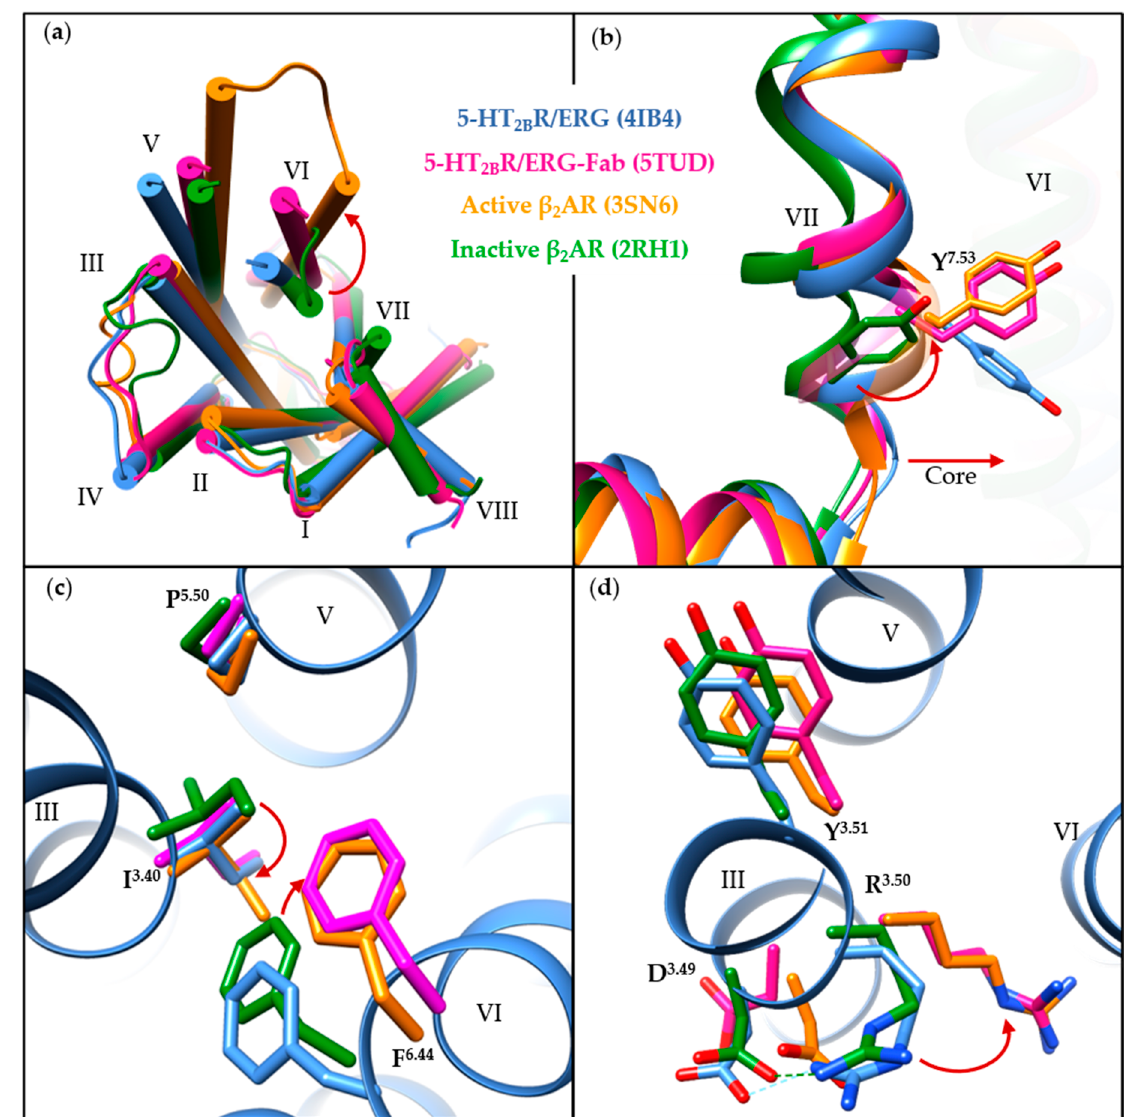
Figure 3. A comparison of the 5-HT 2B R/ERG (cornflower blue, PDB ID: 4IB4), the 5-HT 2B R/ERG-Fab (magenta, PDB ID: 5TUD), the active-state β 2 AR (orange, PDB ID: 3SN6) and the inactive-state β 2 AR (forest green, PDB ID: 2RH1) crystal structures. ( a ) Intracellular view of the overall architecture. The outward movement of helix VI upon activation is indicated by a red arrow. ( b ) A comparison of structural features in helix VII. The slight inward movement of helix VII and rotation of Y 7.53 in the NPxxY motif towards helix VI are highlighted by red arrows. ( c , d ) A comparison of the residues in ( c ) PIF and ( d ) D(E)RY motifs. For clear visualization, residues apart from the motif are hidden, with the exception of the 5-HT 2B R/ERG structure (PDB ID: 4IB4). The obvious conformational changes of specific residues upon activation are shown as red arrows. Molecular images were generated using the UCSF Chimera software